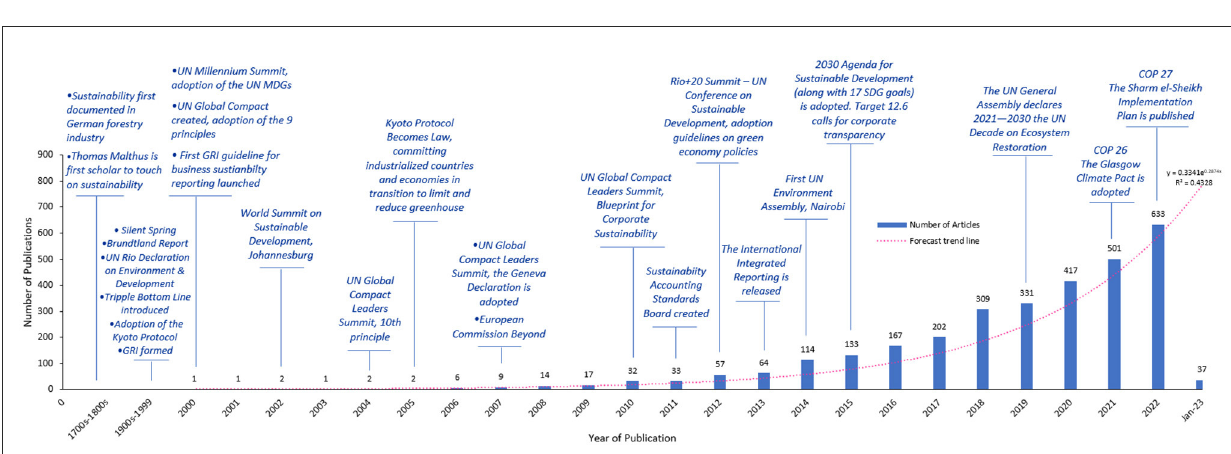
FIGURE3 Trajectory of SSCM publications set against major events in the sustainability